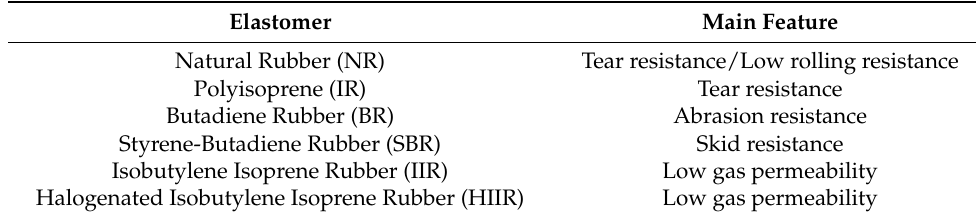
Table 2. Elastomeric polymers used in tyre compound [29].